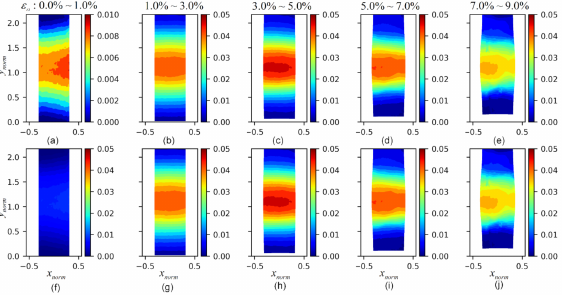
Figure 7. The evolution of the mean fields of gradient along the ˆ ρ axis F 11 : ( a – e ) mean fields of F 11 at axial strains of 0.0–1.0%, 1.0–3.0%, 3.0–5.0%, 5.0–7.0%, and 7.0–9.0%, respectively, with varying range colormaps; ( f – j ) mean fields of F 11 at axial strains of 0.0–1.0%, 1.0–3.0%, 3.0–5.0%, 5.0–7.0%, and 7.0–9.0%, respectively, with consistent range colormaps.